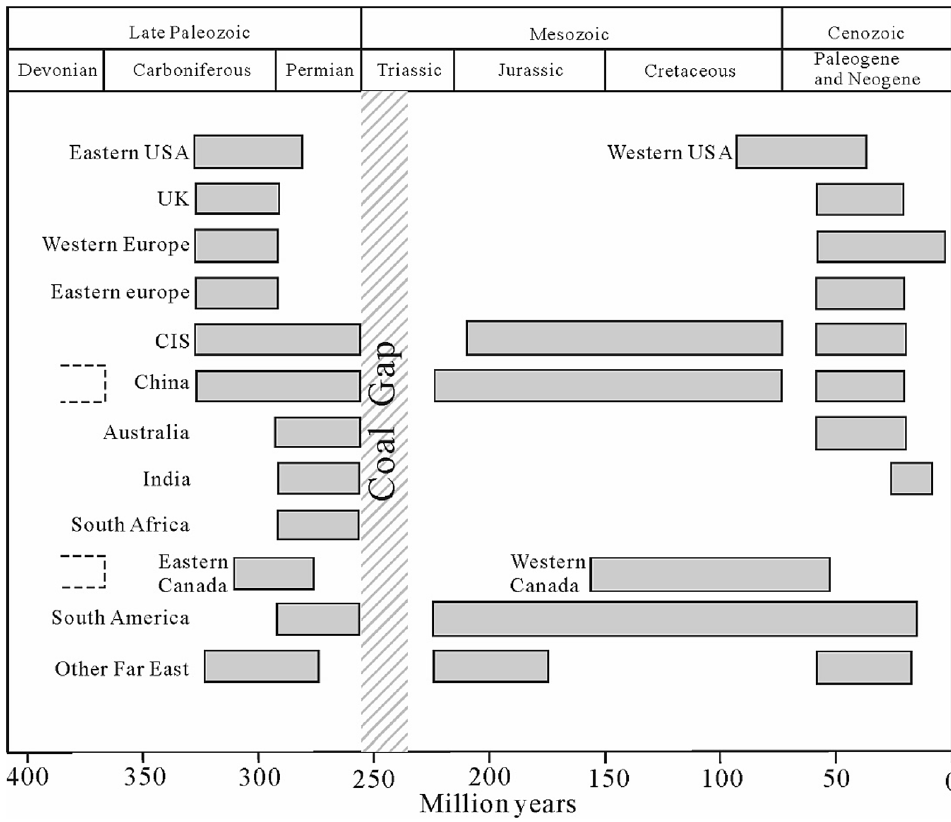
Fig. 2 Distribution of coal deposits of the different ages in the world. Modified after Thomas